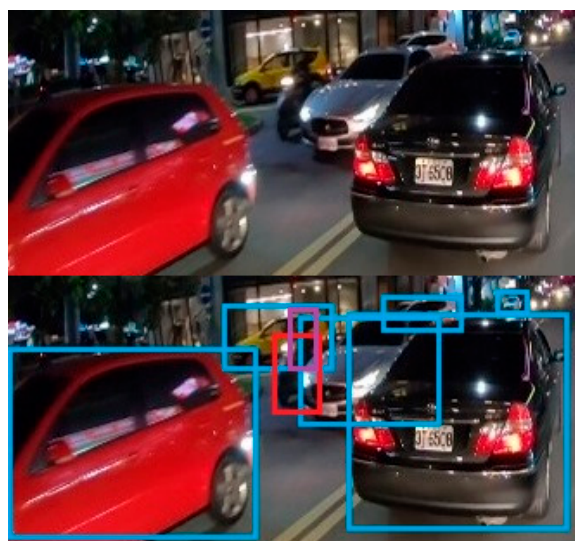
Figure 7. Occluded motorbikes with clearly visible outlines and noteworthy features. Left : Part cropped from unlabeled data. Right : Part cropped from labeled data.